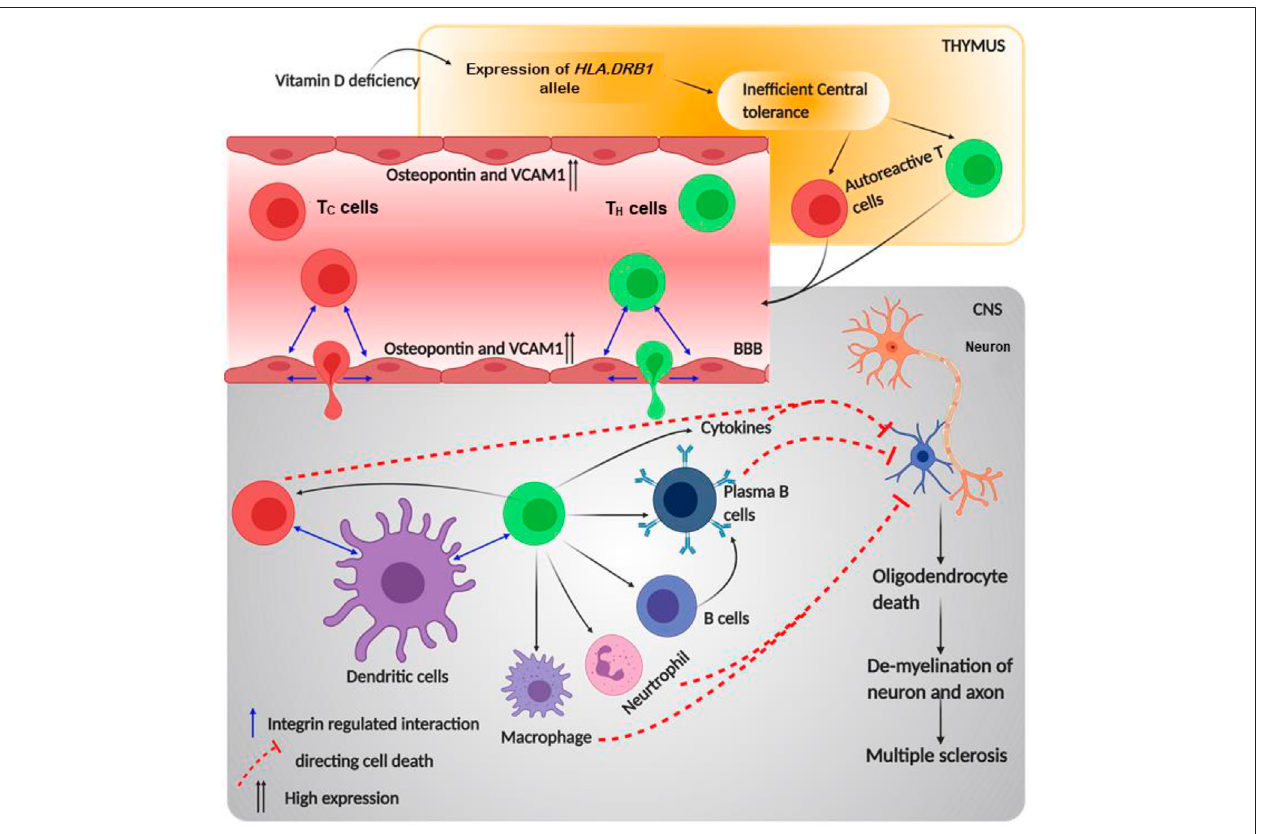
FIGURE6| Schematicdiagramofmultiplesclerosispathophysiologyandroleofintegrininitsprogression:the fi gureprovidesaschematicdiagramofhowmultiple sclerosis develops and what points of this disease are regulated by integrin. Blue arrows denote signaling or mechanism being regulated by integrins.